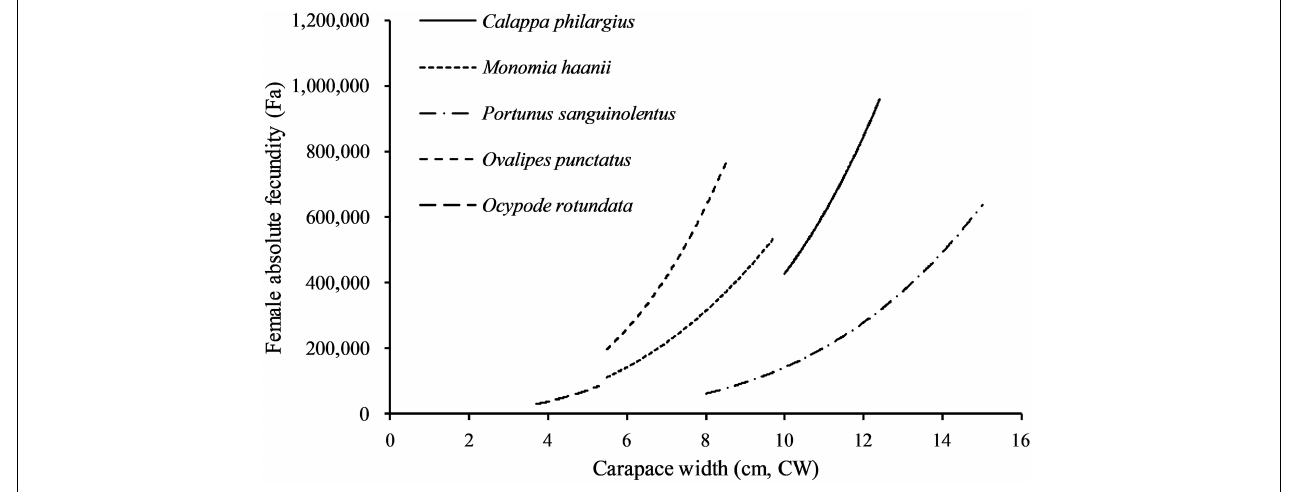
FIGURE 9 | Comparison of the absolute fecundity ( Fa , eggs/female) and size (carapace width, CW) relationship of crabs